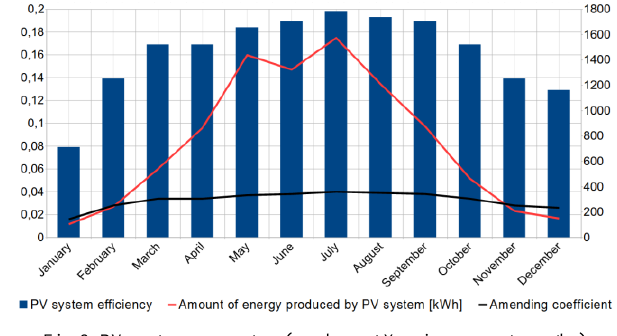
Fig. 3. PV system parameters (numbers at X axis represent